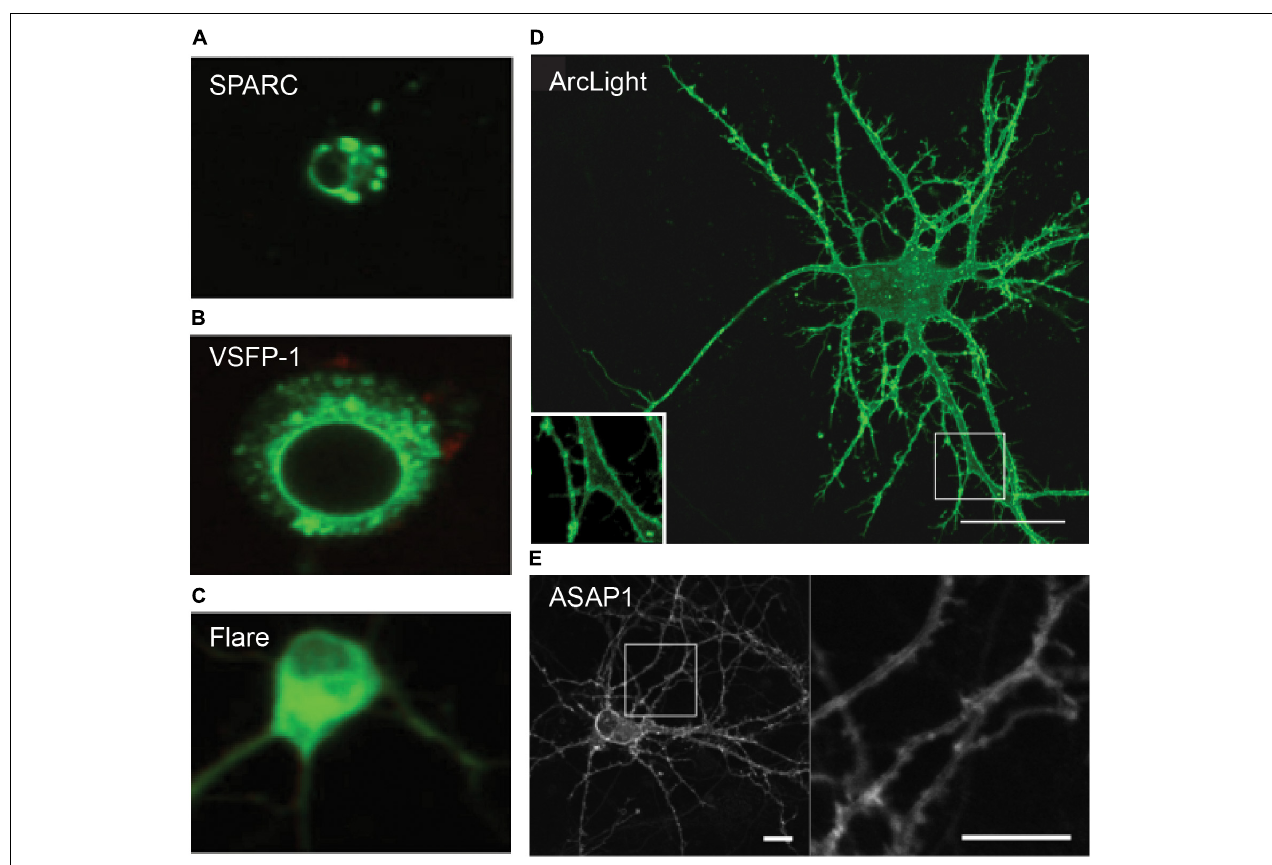
FIGURE 2 | Confocal images of GEVI expression in dissociated hippocampal neurons. (A–C) Ion channel-based GEVIs SPARC, VSFP-1 and Flare exhibit poor membrane localization and “web-like” intracellular aggregates, suggestive of protein retention in the ER. (D,E) VSD-based voltage sensors Arclight and ASAP1 show excellent membrane expression, which is clearly visible even in subcellular compartments such as dendrites (insets). Scale bars = 10 µ m (Baker et al., 2007; Jin et al., 2012; St-Pierre et al., 2014).